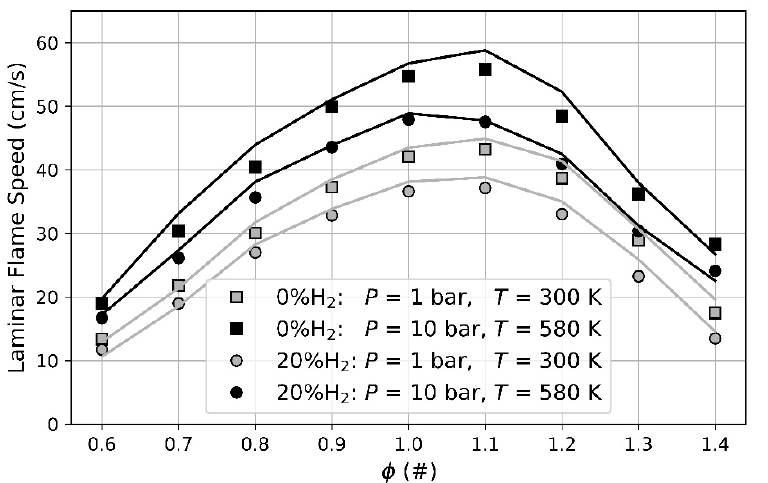
Figure 2. Comparison between laminar flame speed from premixed flame experimental data (mark- ers) and chemical kinetics simulations (solid lines) for pure methane and a methane–hydrogen blend. The effect of the fuel–air normalized ratio is shown for two environmental pressure-temperature conditions.